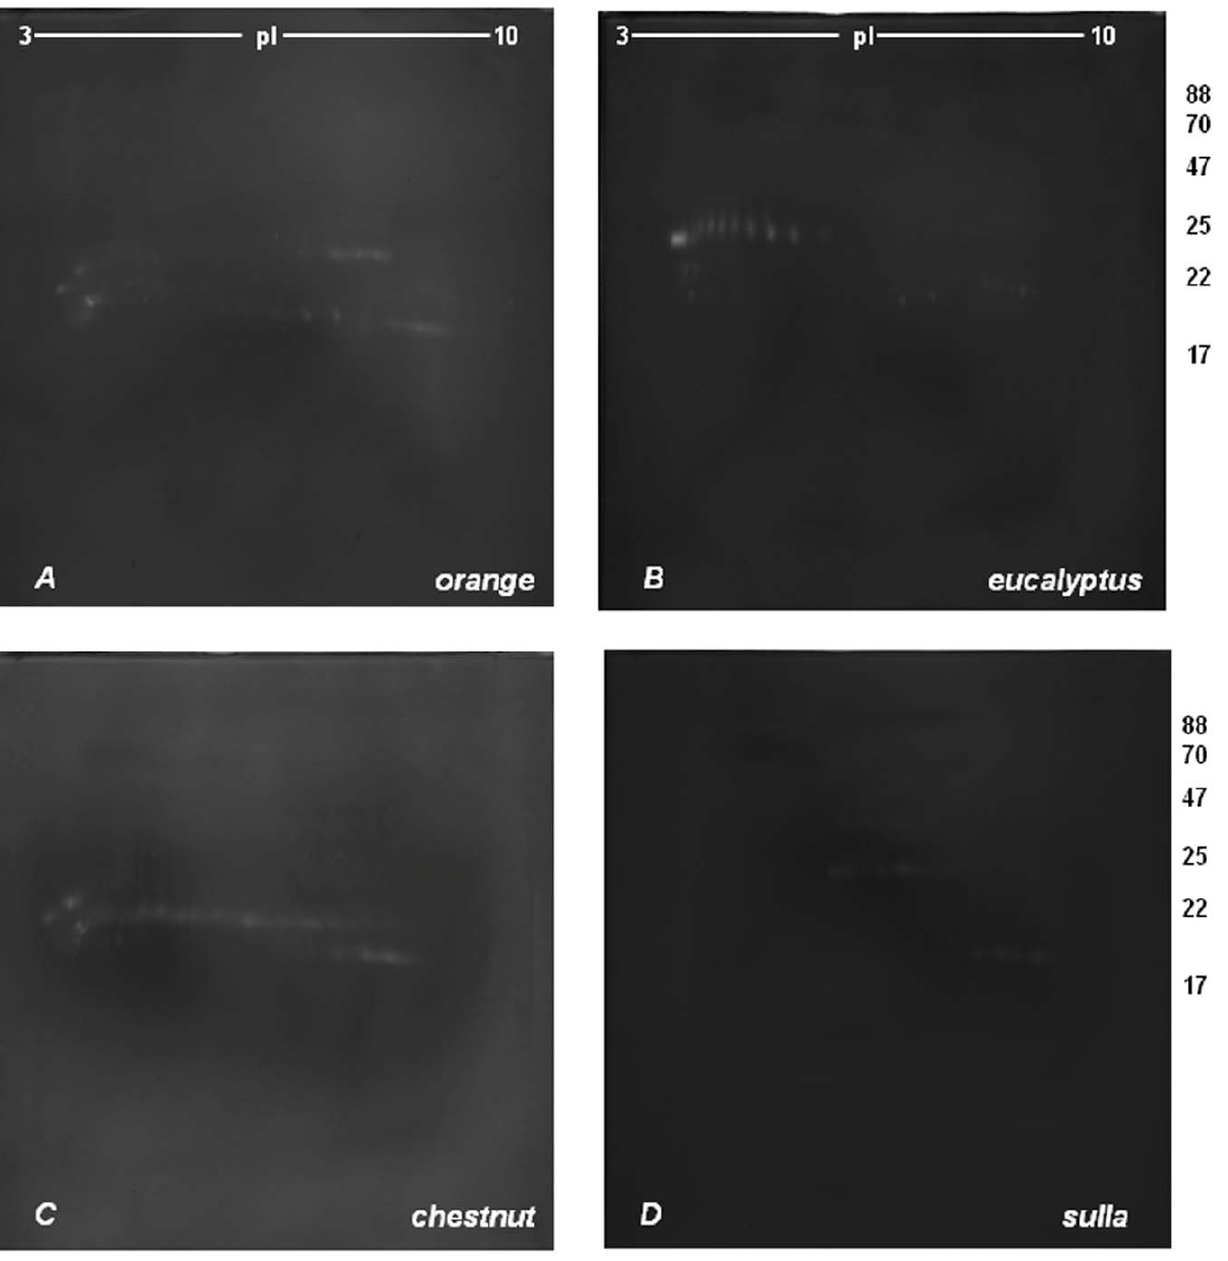
Figure 4. 2-D zymography (2-DZ) of the proteolytic activities present in honey PZ2 extracts. Proteolytic activities were detected by 2-D zymography on gels copolymerized with gelatin. Gels: A ( orange honey), B ( eucalyptus honey), C ( chestnut honey) and D ( sulla honey). 80 m g of proteins were applied to each gel.